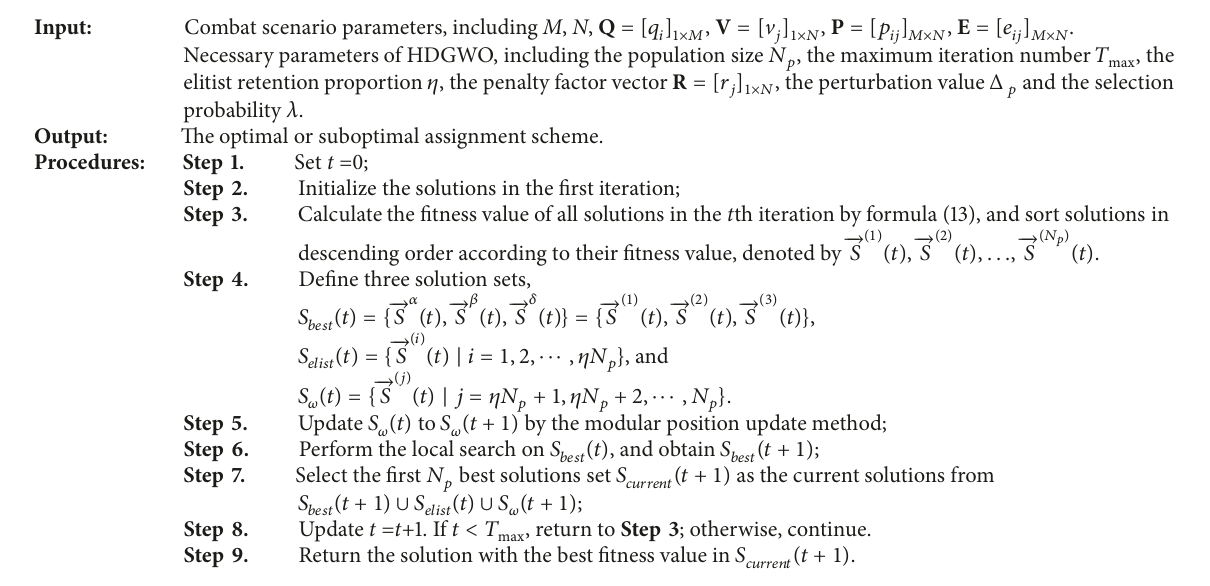
Algorithm 4: Pseudo-code of HDGWO.